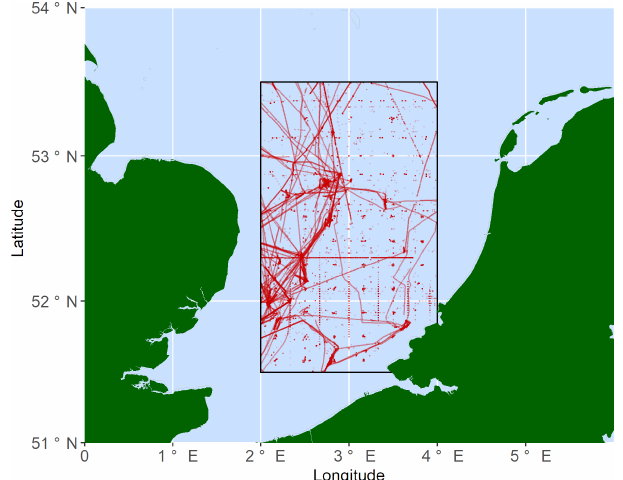
Figure 8. Illustration of near-surface (0–5m) data coverage in the southern North Sea. Plotted point intensity reflects data density. Note that the area inside the West Frisian Islands is primarily sand- banks and reclaimed land, not